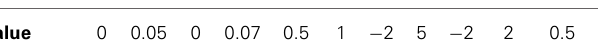
FIGURE 5 | Optimal decision thresholds, probability of correct and mean reaction times in example 3. (A) The optimal value of the decision threshold in condition 1, a opt 1 , and condition 2, a opt 2 , for different values of the parameter μ 1 1 in the interval [0 . 05 , 0 . 2] . (B) The probability of a correct response in condition 1 (denoted as P C 1 ) versus condition 2 (denoted as P C 2 ). (C) The mean time spent on condition 1 ( ¯ T 1 ) and condition 2 ( ¯ T 2 ). In all figures, the points corresponding to μ 1 1 = 0 . 05 , 0 . 1 and 0 . 2 are specified by